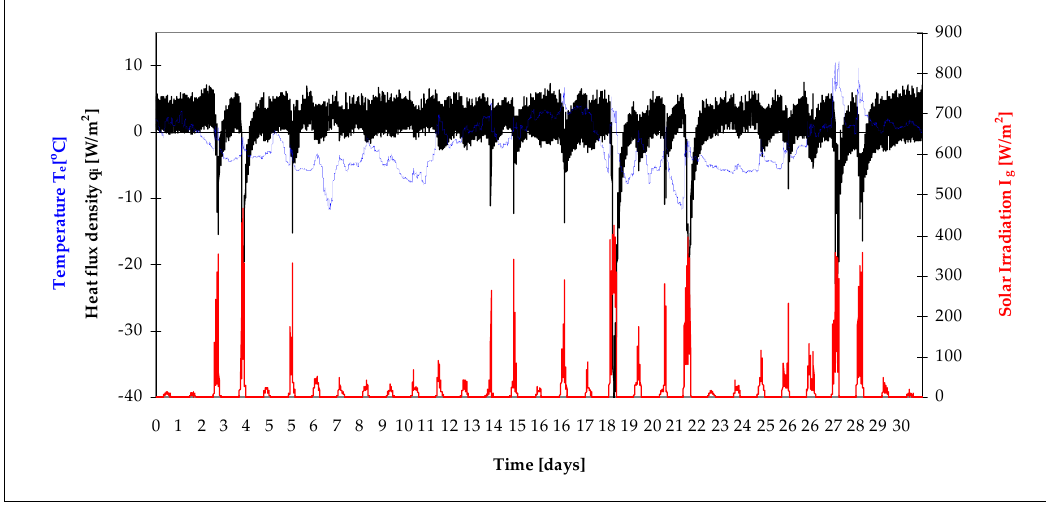
Figure 10. Distribution of air temperature Te , heat flux density measured on the inner surface of the IGW and solar irradiation measured behind the outer glazing in January 2019.